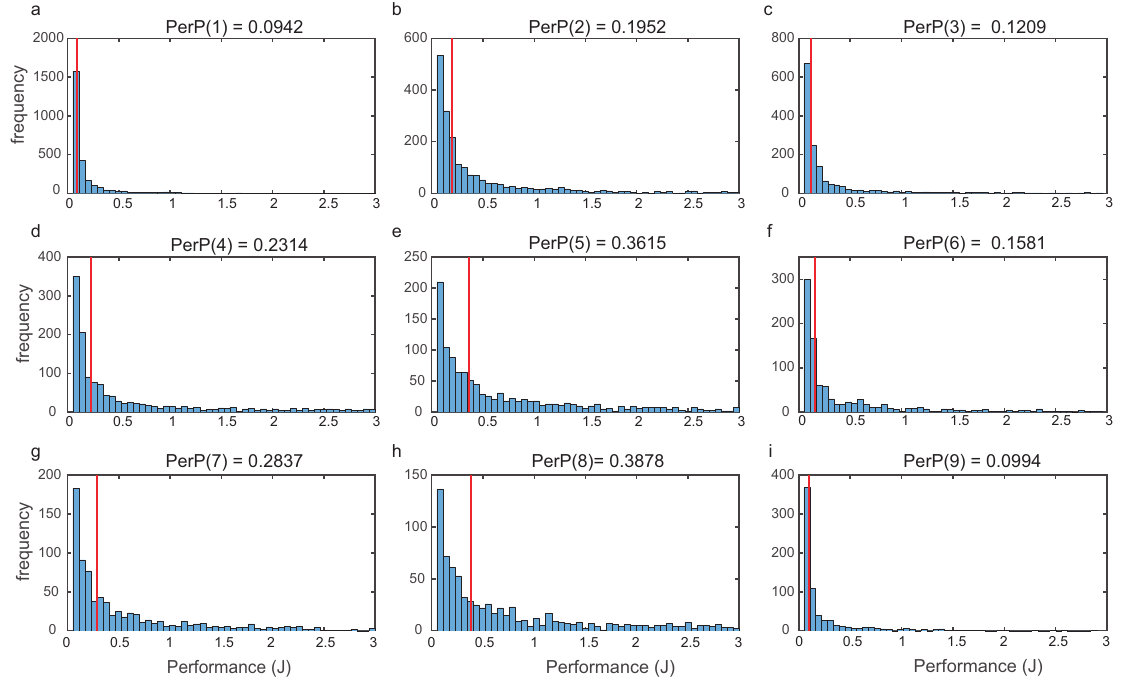
Figure 5. Frequency distributions of the cost (performance J ) for each of the nine most frequent structures. Medians are indicated in